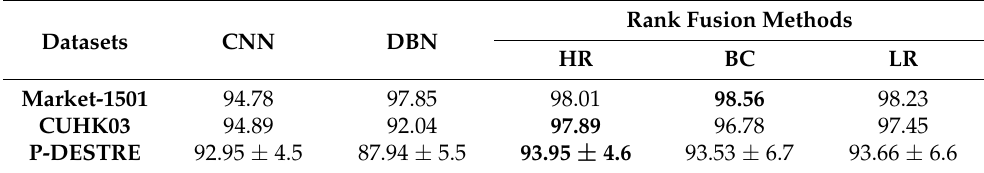
Table 10. mAP of the developed ReID-DeePNet system on three different ReID datasets using rank-level